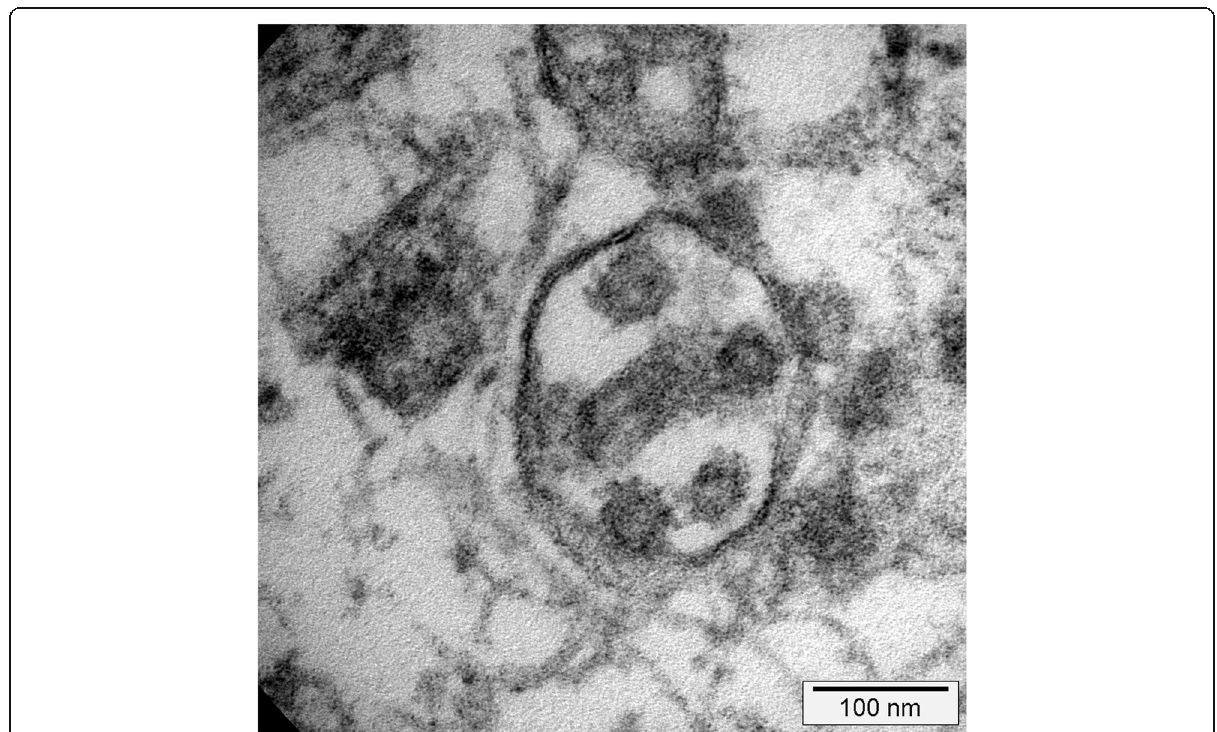
Fig. 1 Electron micrograph of the intracellular virus-like particles of a COVID-19 victim ( “ Courtesy of Martin Herzig for technical preparation and performing the microphotography ”